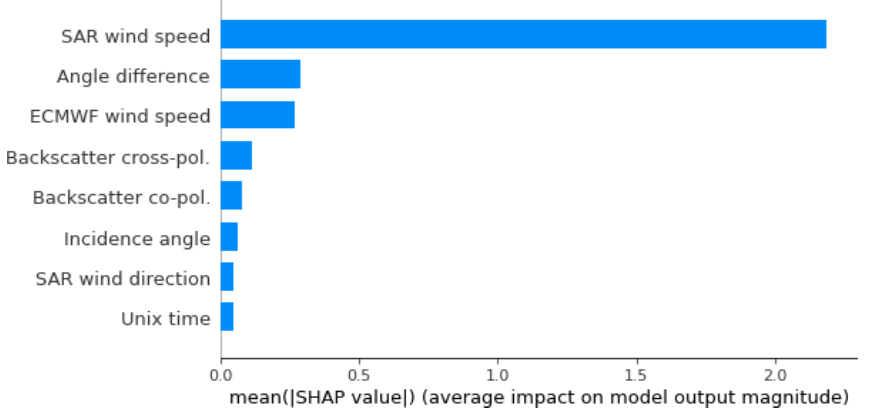
Figure 4. Relative importance of the input parameters used to correct SAR surface winds.